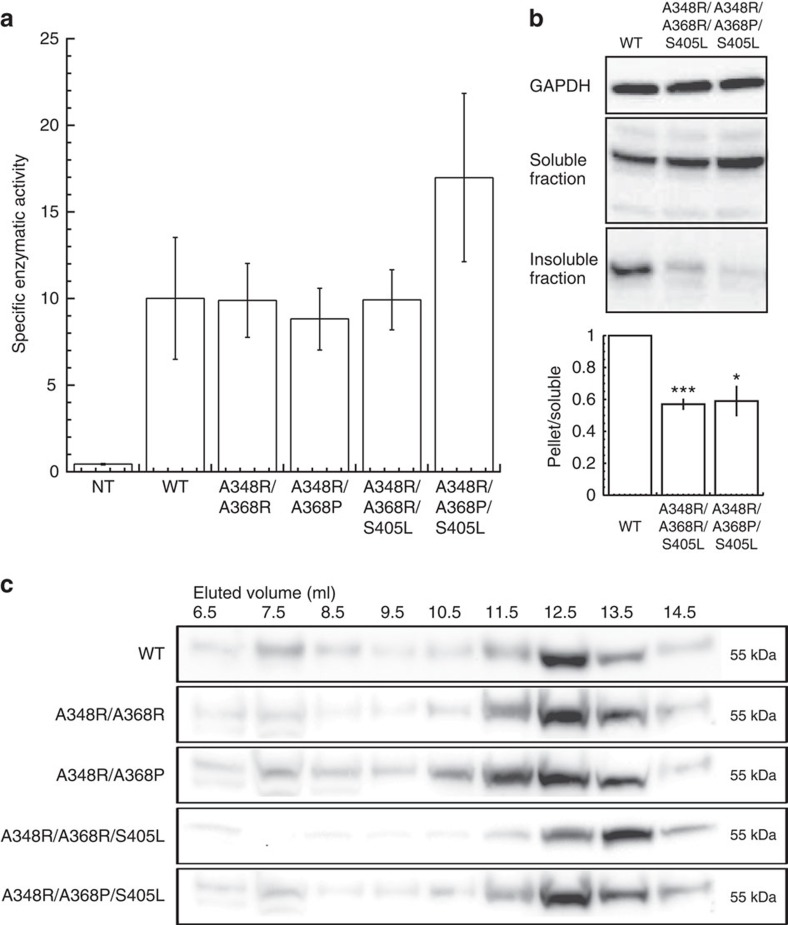
Effect of double and triple mutants on α-Gal aggregation and activity.(a) Quantification of the enzymatic activity of WT α-Gal and double and triple mutations in transiently transfected HeLa cells. The activity of the improved mutants was ∼twofold higher than the WT protein. Statistically significant values as compared with WT are indicated: ‘***' P< 0.001 and ‘****' P<0.0001. Data are means from three independent experiments; error bars show s.e.m. (b) Western blot of the level of WT α-Gal and mutants in the soluble and insoluble fraction of transiently transfected HeLa cells. The fraction of the mutants that is found in the insoluble fraction is significantly lower than for WT α-Gal (barplot, result of four repeats). (c) Western blot of SEC fractions of WT and double and triple mutants in transiently transfected HeLa cells. WT α-Gal and improving mutants eluted in later fractions (12.5–14.5 ml) corresponding to the active soluble form of the protein.